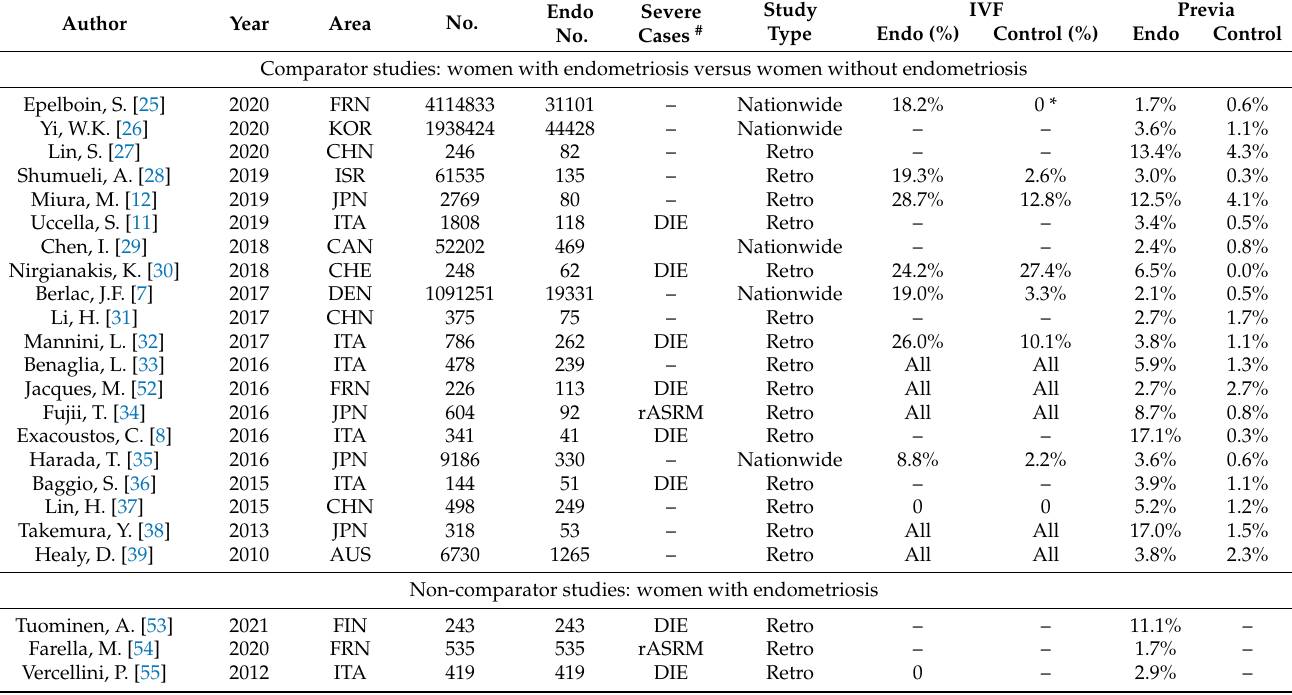
Table 1. Influence of endometriosis on the incidence of placenta previa